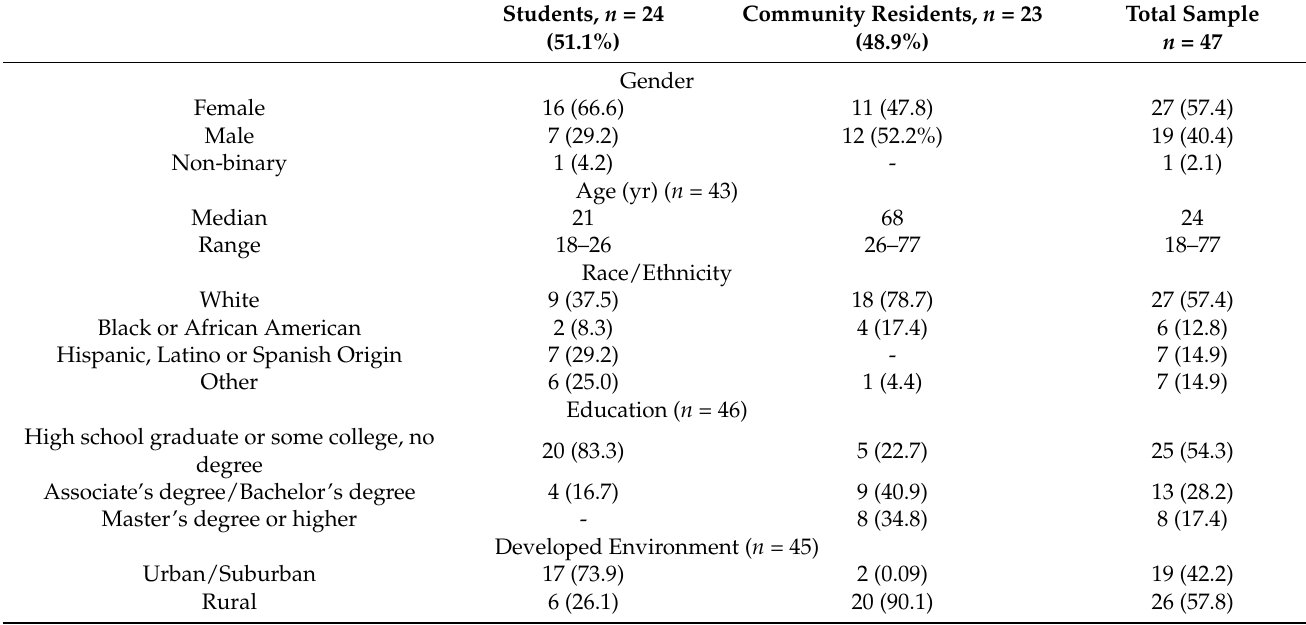
Table A1. Demographic characteristics of study